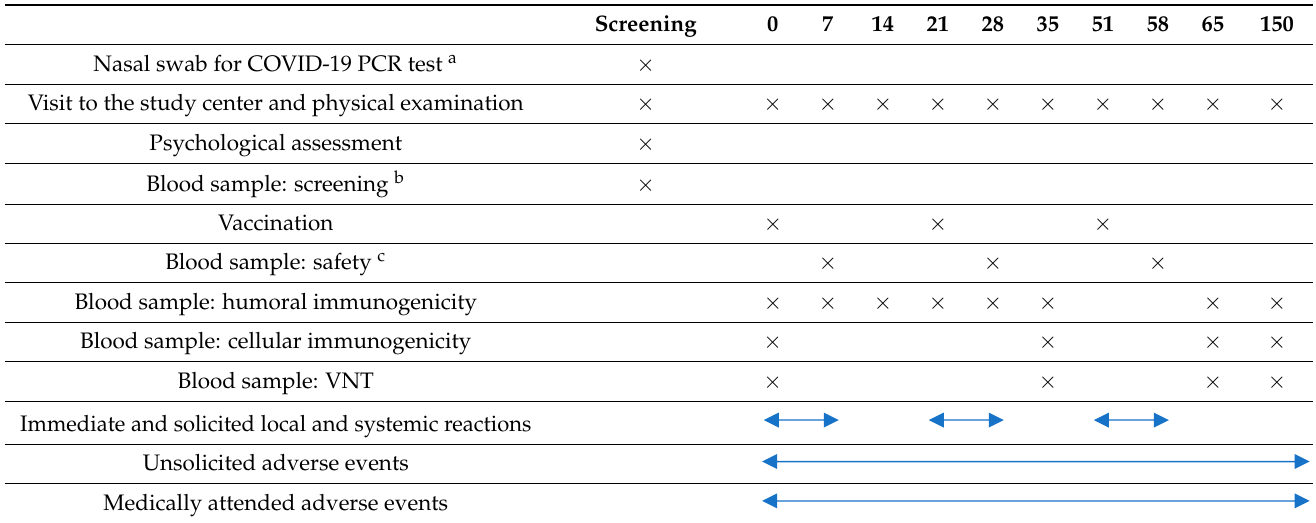
Table 1. Predefined time schedule of this study.